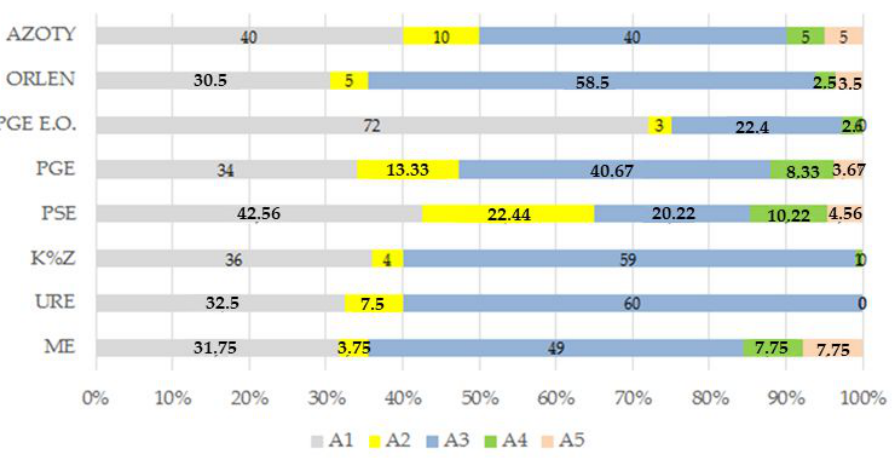
Figure 3. Percent load distribution of regulation